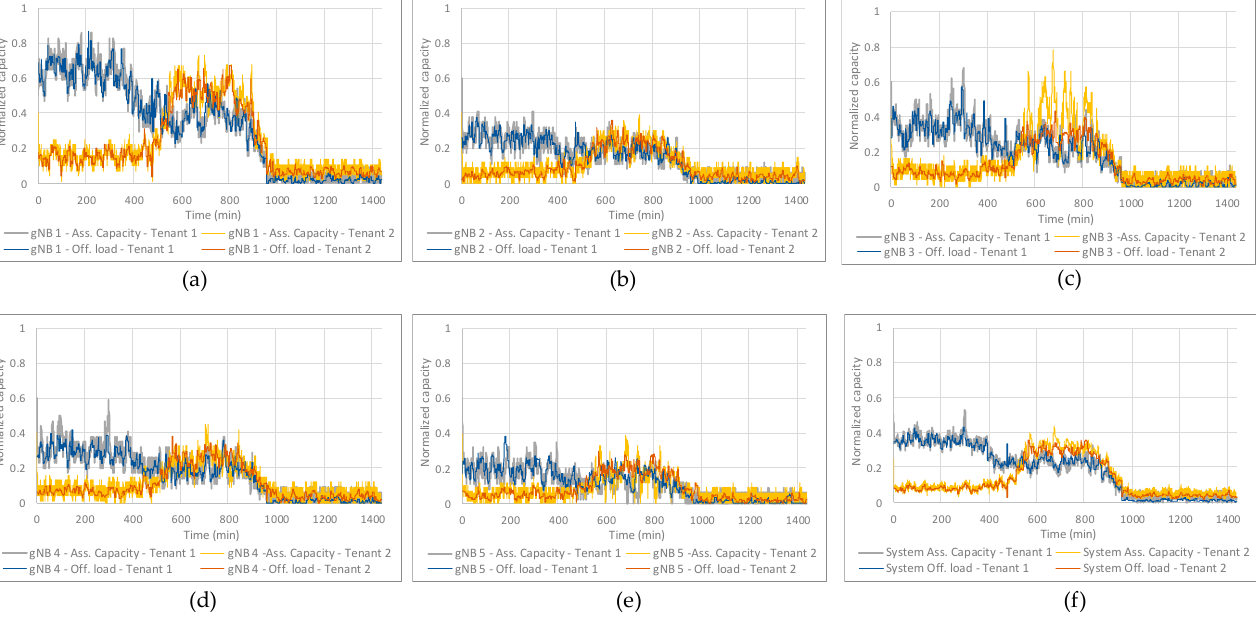
Figure 6. Comparison of the offered loads and the assigned capacity per tenant for ( a ) gNB 1, ( b ) gNB 2, ( c ) gNB 3, ( d ) gNB 4, ( e ) gNB 5 and ( f ) at system level. The required capacities are generally satisfied, showing that the policies have been successfully trained on the RAN